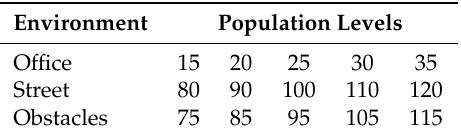
Table 1. Different size levels of the human populations in each environment. In each case, the median value corresponds to 1/3 of valid spawn points for human agents in the corresponding